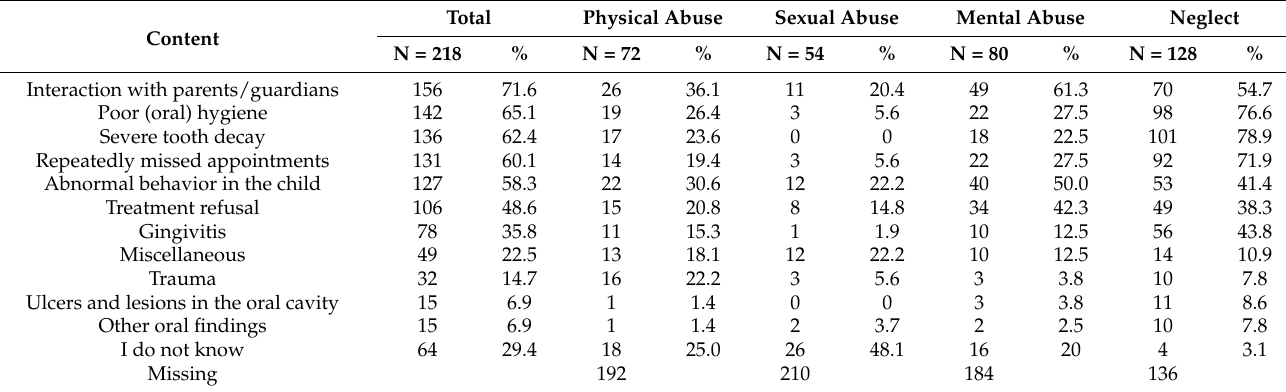
Table 3. Reasons for suspected child maltreatment (N total =